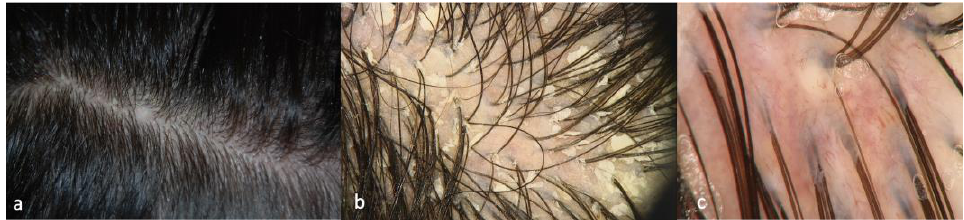
Figure 1. Clinical ( a ) and trichoscopic findings of Patient 1, ( b ) 20× magnification, and ( c ) magnification 40×.